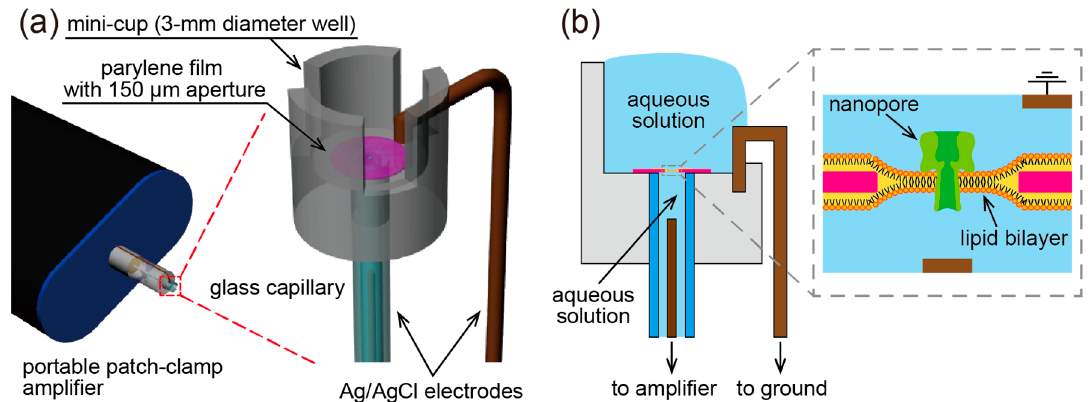
Figure 1. ( a ) Schematic of a lipid-bilayer-on-a-cup device named the mini-cup. The mini-cup device, mounted on a patch-clamp amplifier, consists of a 3 mm diameter well with a perforated polymer thin film at its bottom. The reverse side of the film is connected to the amplifier via a glass capillary. ( b ) Cross-sectional view of the mini-cup device. The well and the capillary are filled with aqueous solutions. At the aperture of the film, a lipid bilayer is formed and a nanopore protein is reconstituted. A pair of electrodes are used to monitor the ionic current through the nanopore.